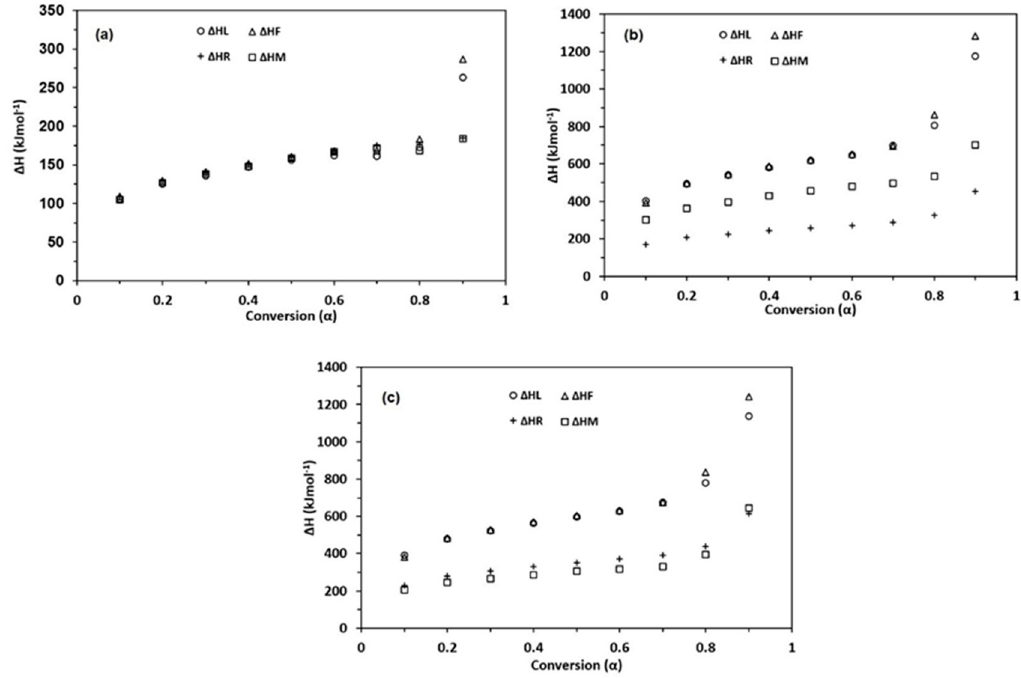
Figure 4. The enthalpy changes of DPWP as determined by the ( a ) FWO, ( b ) KAS, and ( c ) Starink model-free methods.